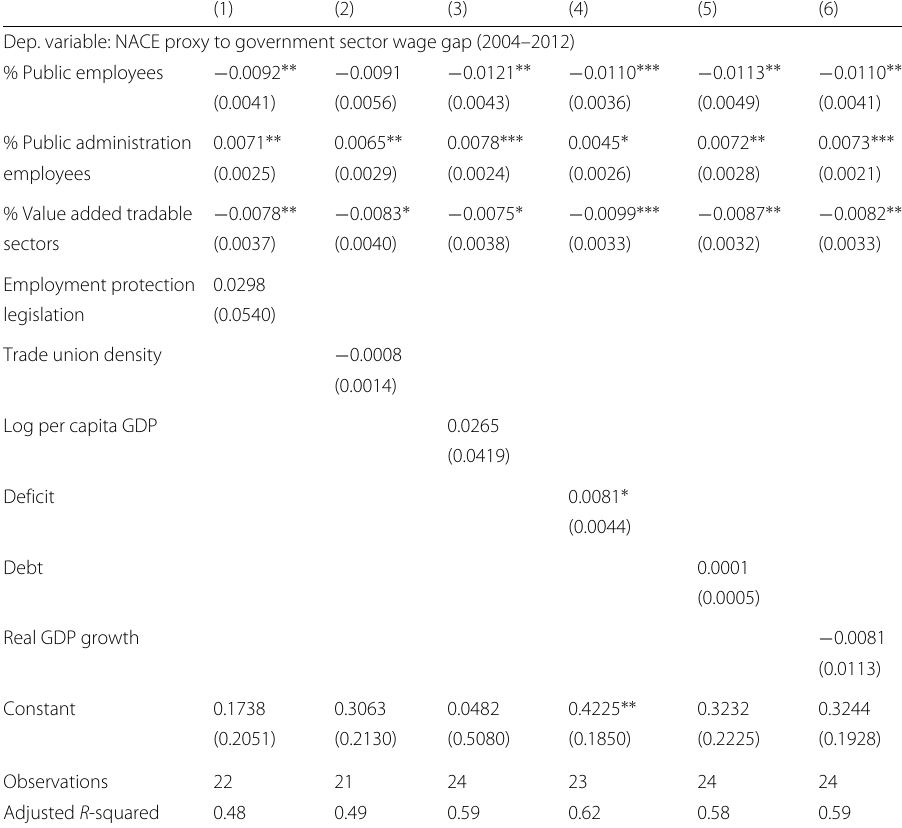
Table 9 Determinants of the public sector pay gap: government monopolistic power and wage-setting institutions